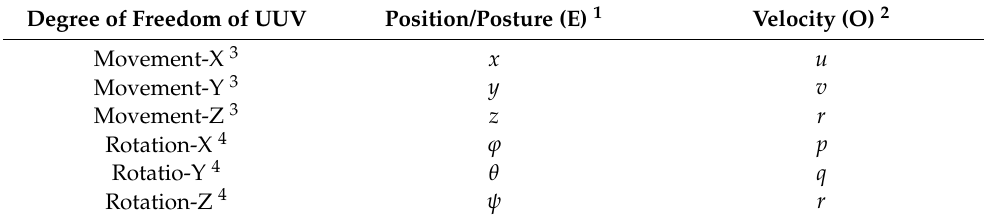
Table 1. Correspondence table of the two coordinate systems of the kinematic model. Degree of Freedom of UUV Position/Posture (E) 1 Velocity (O) 2 Movement-X 3 x u Movement-Y